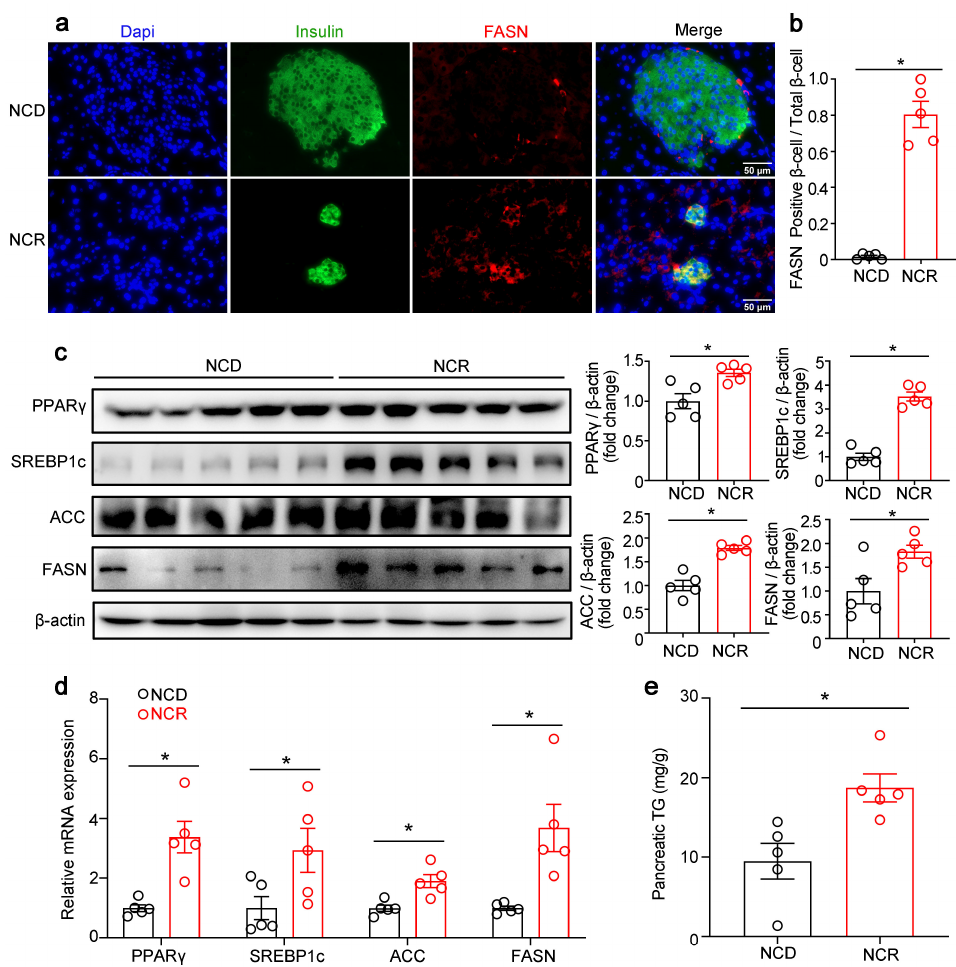
Figure 3. CR increased the lipogenic gene expression in pancreas of normal chow diet-fed mice. ( a ) Representative immunofluorescence images of fatty acid synthase (FASN, red) and insulin (insulin, green). ( b ) Quantification of FASN-positive β -cells/total β -cells. ( c ) Representative Western blot of mouse pancreas. PPAR γ , SREBP1c, ACC, and FASN were measured. Quantification of PPAR γ , SREBP1c, ACC, and FASN. ( d ) PPAR γ , SREBP1c, ACC, and FASN mRNA levels. ( e ) Pancreatic triglyceride. The results were expressed as mean values ± SEM. ( n = 5 per group) * p < 0.05 vs. NCD mice.